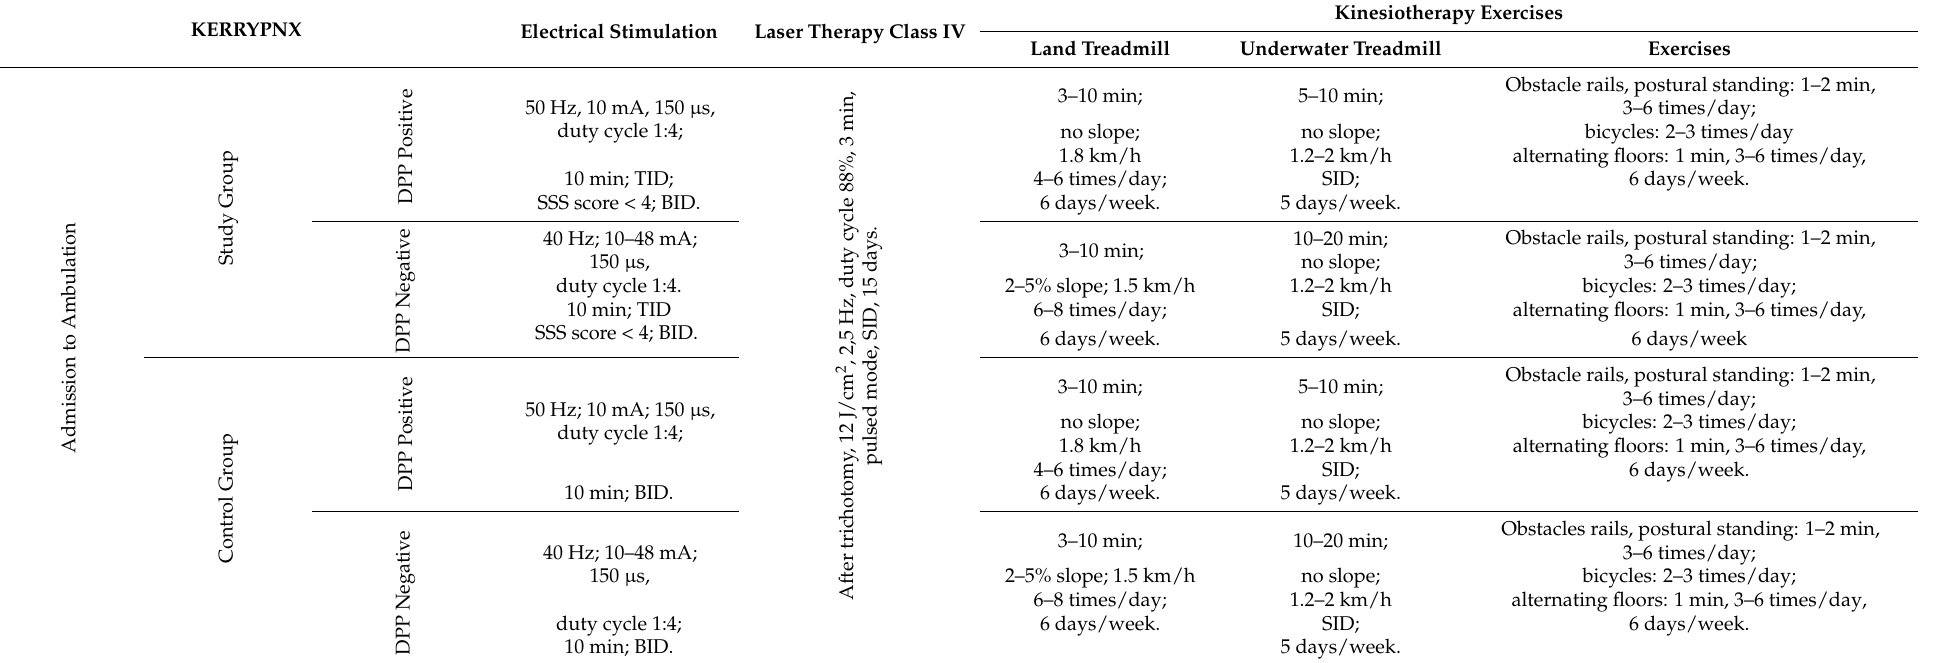
Table 3. Intensive neurorehabilitation